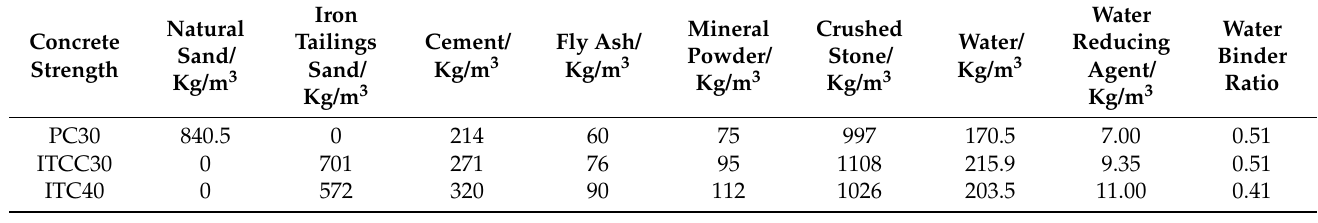
Table 2. Mix proportion of concrete.